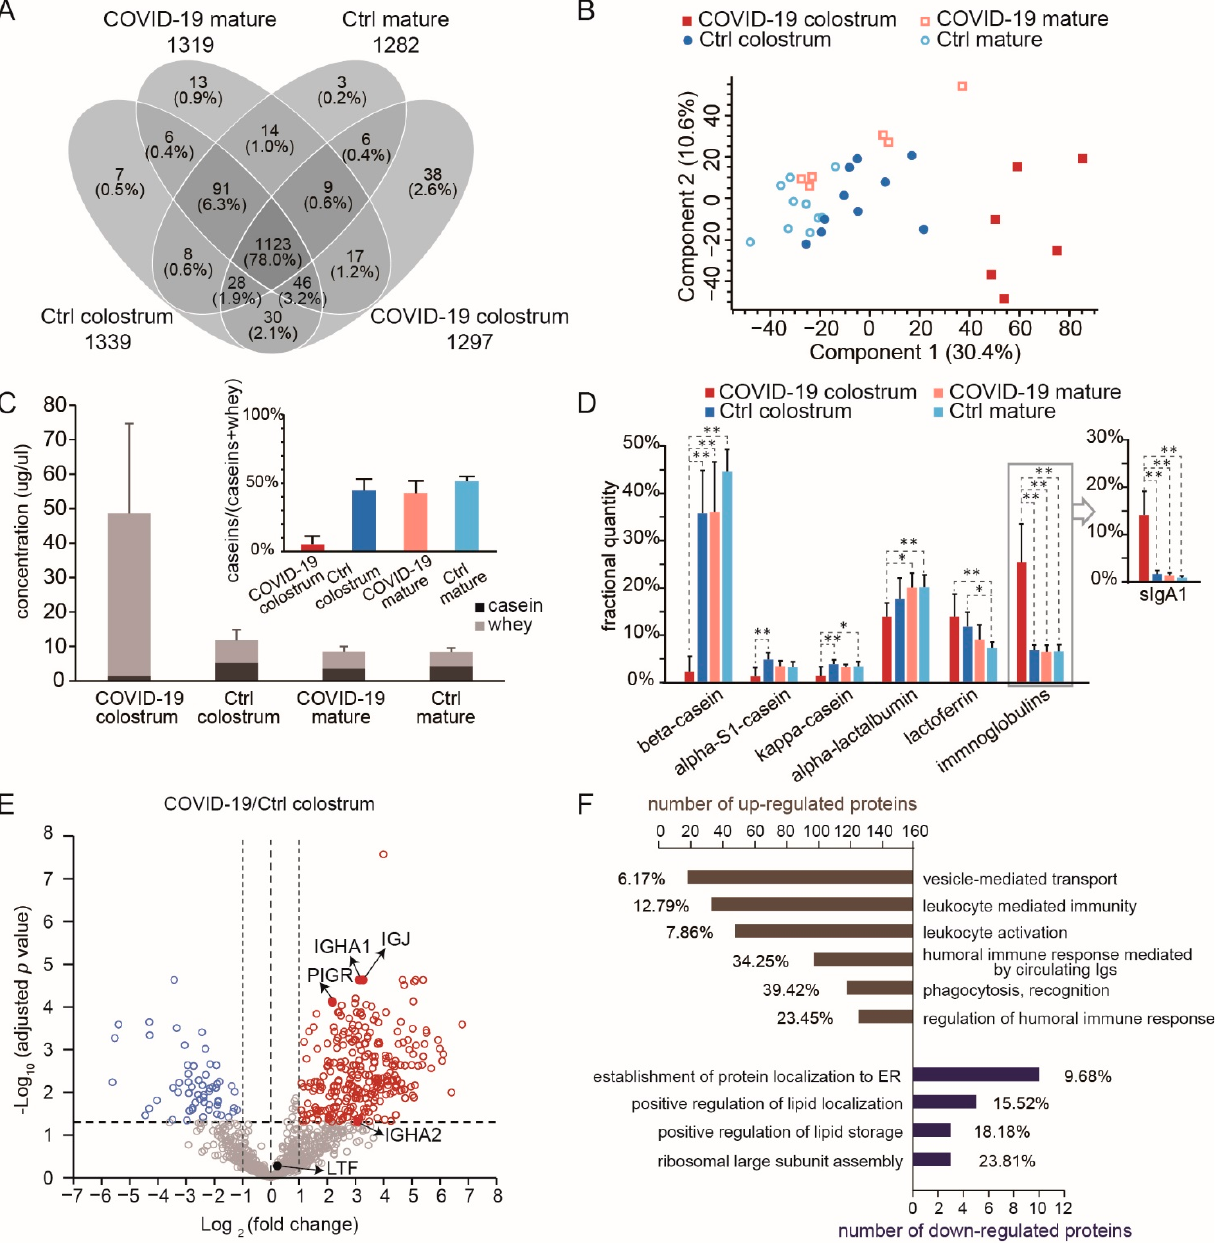
Figure 2. Comparison of human milk proteomes in different sample groups. ( A ) A Venn diagram showing the numbers of proteins that could be quantitatively monitored. The number of proteins for each group are shown below the group name. ( B ) Principal components analysis results of the milk proteome. ( C ) Bar graphs of the quantities of casein (black) and whey (gray) proteins. The inset shows the fractions of caseins. Bars indicate means and whiskers indicate SDs. ( D ) Comparisons of the fractional quantities of major milk proteins. For one-way ANOVA with Tukey HSD test, * p < 0.05, ** p < 0.01. ( E ) A volcano plot showing proteome changes between COVID-19 colostrum and Ctrl colostrum groups. ( F ) Significantly enriched biological processes of differently expressed proteins ( p of each GO term < 0.0002). The graph shows both numbers and percentages of differently expressed proteins in each term group.